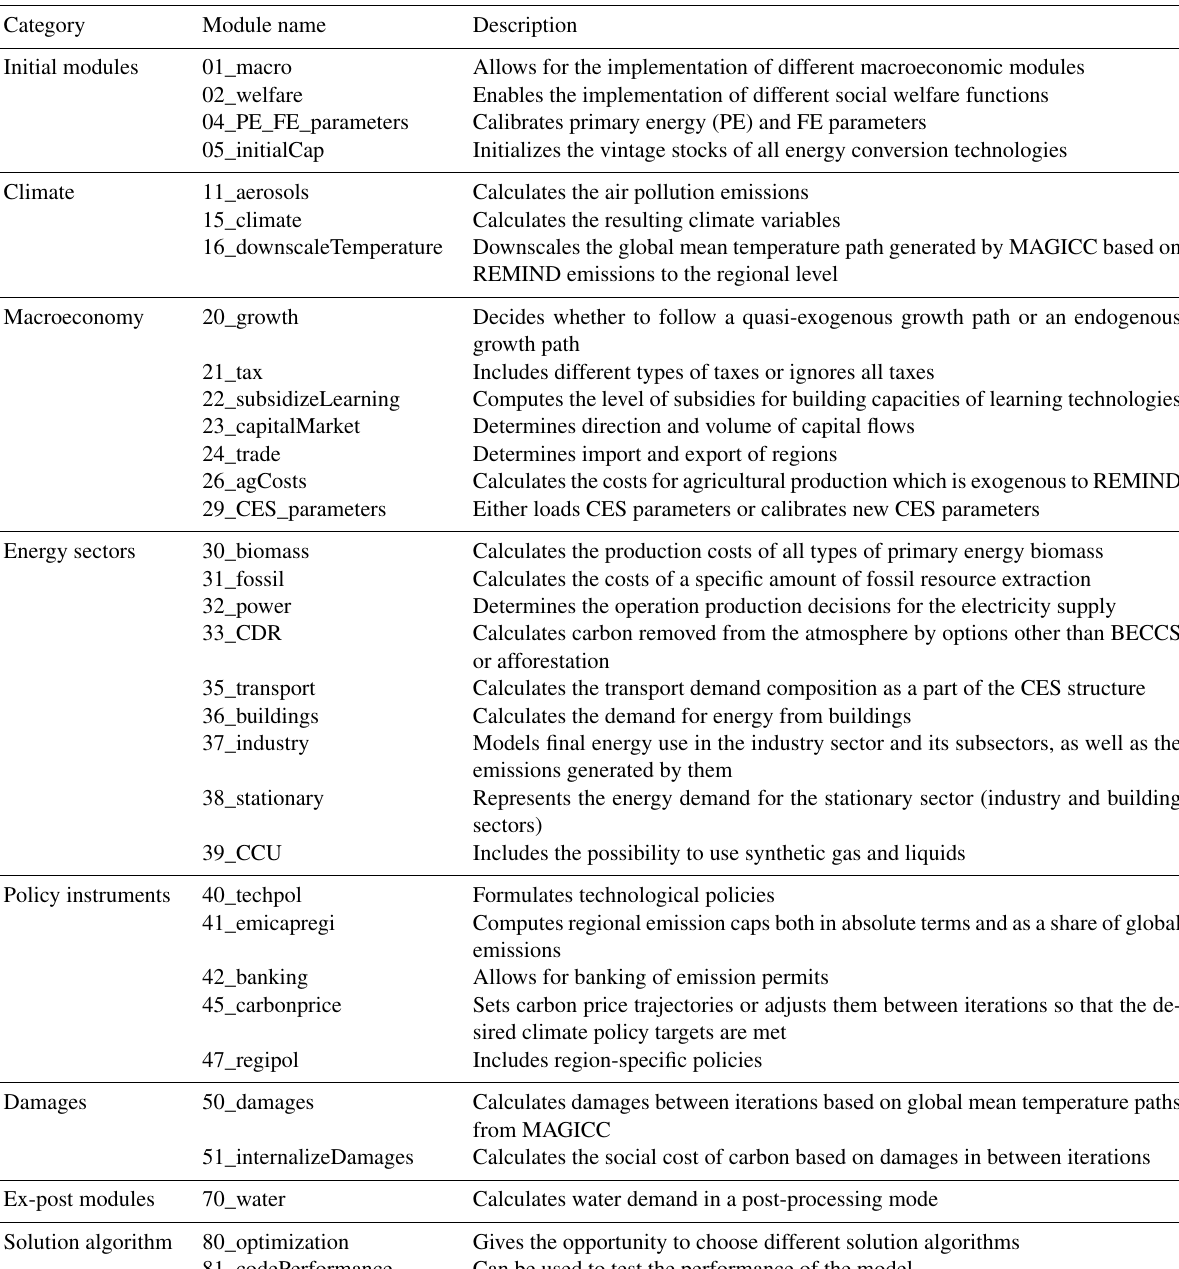
Table C1. Modules of REMIND